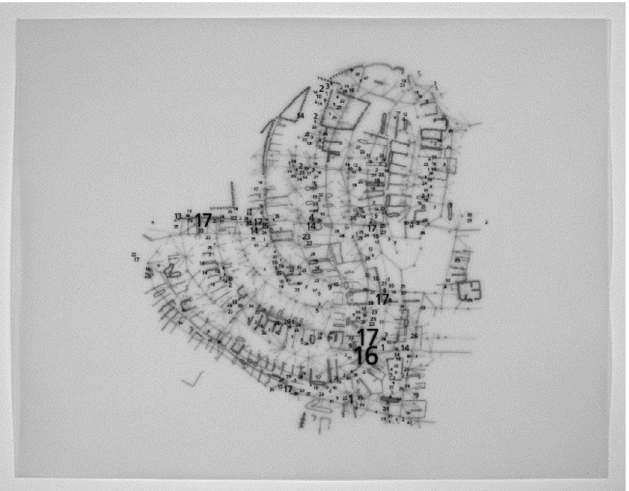
Figure 6. Fences, map by Helen Waldrop ([5], p. 95, used with permission). As glicée prints, this limited edition included the maps of fences, overhead power lines, autumn leaves, police calls, graffiti, and wind chimes. Figure 7 shows us looking down through police calls (the numbers), overhead lines (the dots and lines), and fences. But if it had included the maps of the mains, the hill, the streets, the overhead power and other lines, large trees, and rooflines, you’d be able to look down , pretty deeply, from the tops of the houses through the trees, through the net of the power lines and the pavements to the storm drains below. Depending on the height of the roofline and the depth of the storm drain that could be fifty, sixty feet. That’s pretty deep. Add the map of the stars and…